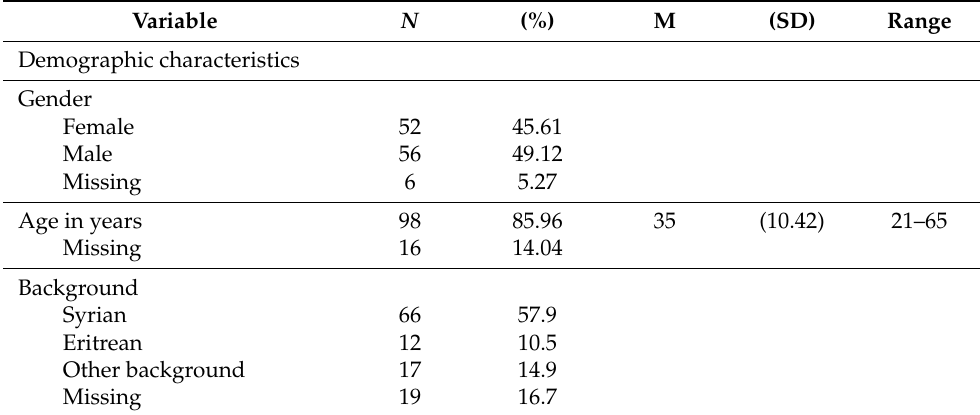
Table 1. Participants’ characteristics ( N =